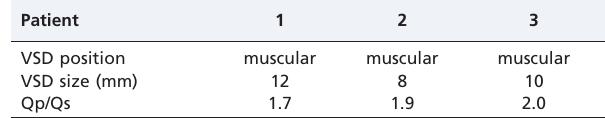
Table 2 - Data from transthoracic echocardiography following initial surgical repair of the